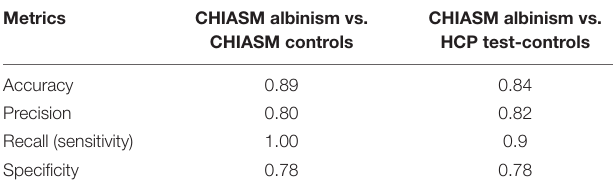
TABLE 2 | Accuracy of cross-group classification based on DSC manual_vs_CNN .